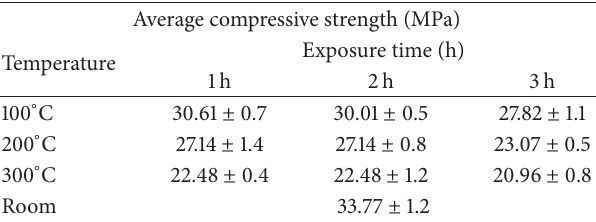
Table 5: Test results of GFRP confined